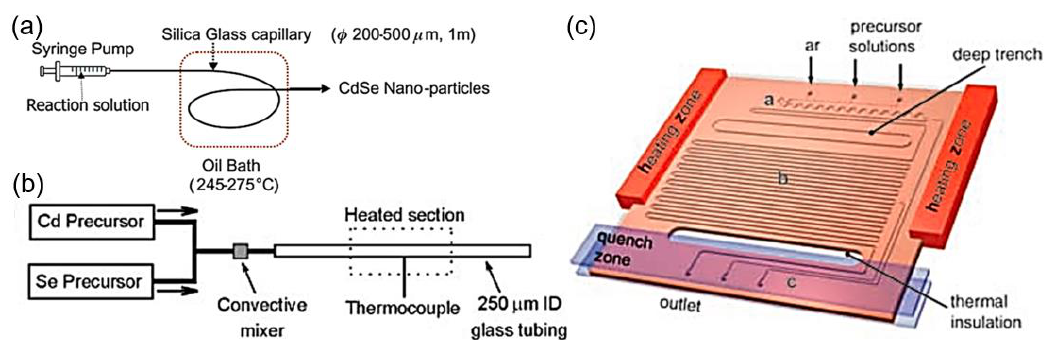
Figure 8. ( a ) Diagram of the flow reactor for the synthesis of CdSe nanoparticles (reproduced from [58], with permission from the Royal Society of Chemistry, 2002). ( b ) Schematic illustration of the capillary reactor for synthesis of CdSe nanocrystals (reproduced from [59], with permission from the Wiley-VCH Verlag GmbH & Co, 2003). ( c ) Schematic illustration of the reactor with heating zone and injected with gas for the synthesis of CdSe QDs (reproduced from [60], with permission from the Wiley-VCH Verlag GmbH & Co,